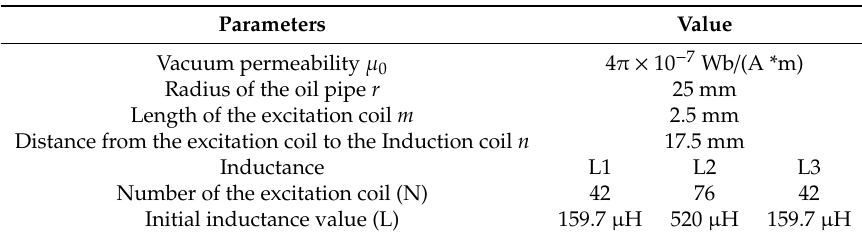
Figure 3. Size of the three-coil winding inductance. Table 1. Parameters of the three-coil winding.